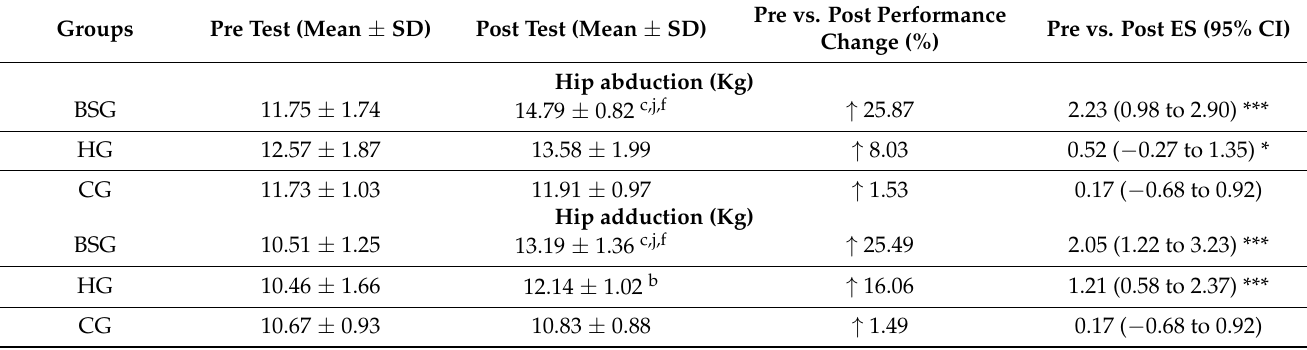
Table 5. Training effects for the strength variables between pre-post intervention and